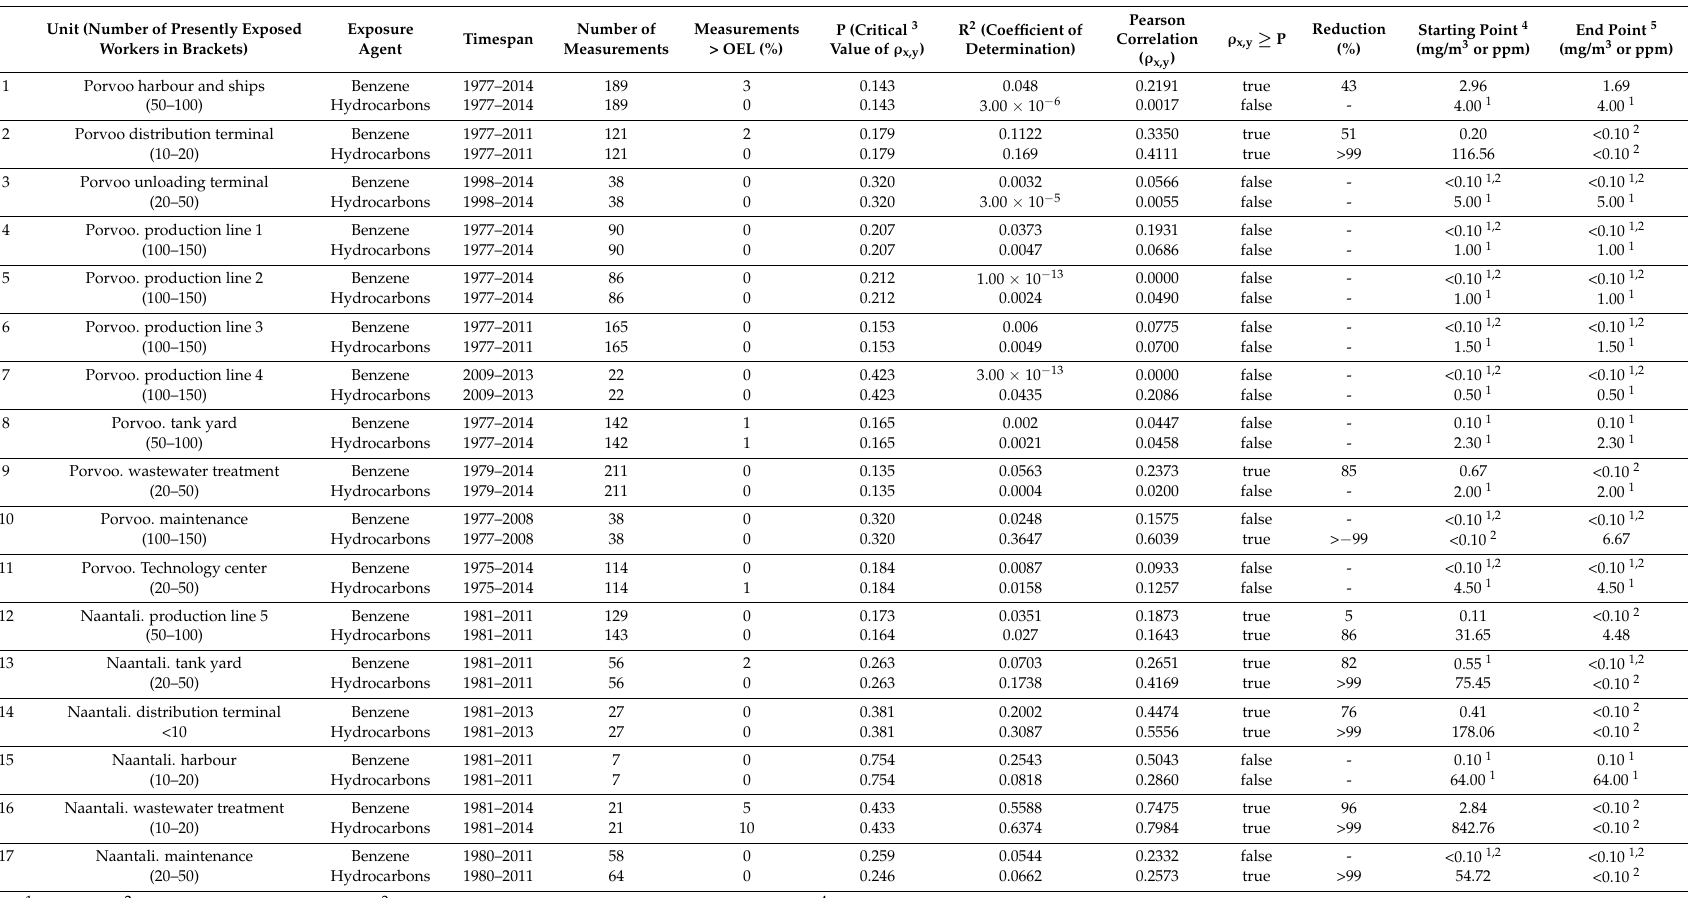
Table 3. Inhalation exposure, measurements and